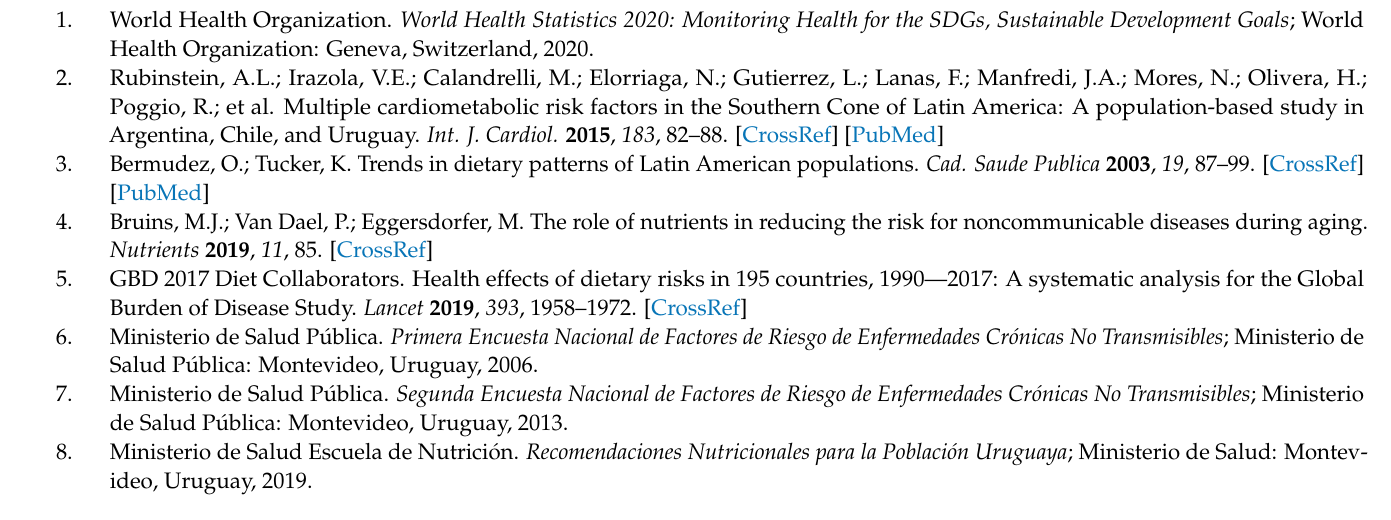
for continuous variables according to tertiles (T) of dietary patterns in Uruguayan adults; Table S6: General adjusted odds ratio (OR) and 95% confidence intervals (CI) for cardiovascular and renal risk phenotypes according to tertiles (T) of dietary patterns and age categories in Uruguayan adults; Table S7: General adjusted odds ratio (OR) and 95% confidence intervals (CI) for cardiovascular and renal risk phenotypes according to tertiles (T) of dietary patterns and sex in Uruguayan